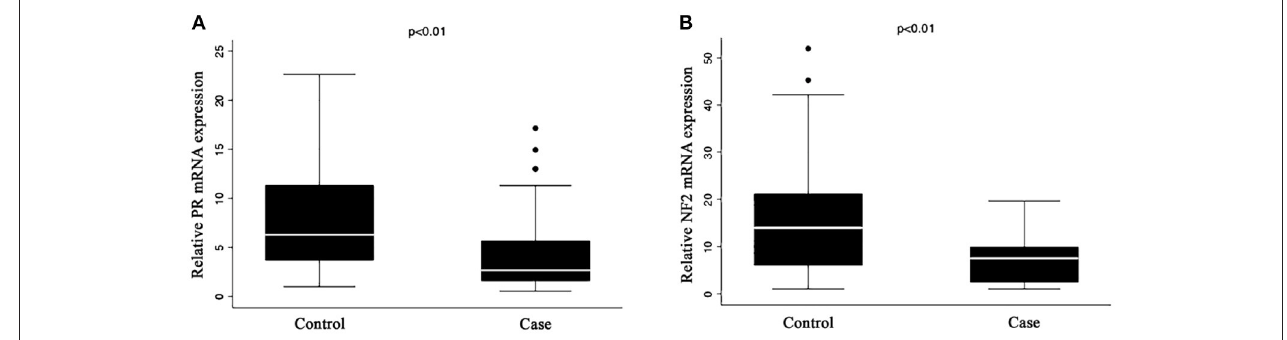
FIGURE 1 | Expression of (A) PR and (B) NF2 mRNA in serum. Quantitative RT-PCR analysis of mRNA expression for (A) PR and (B) NF2 in the serum of case and control group. The mRNA expression levels of PR and NF2 were normalized to the expression levels of GAPDH mRNA in each group. The results represent mean ± S. E. M.